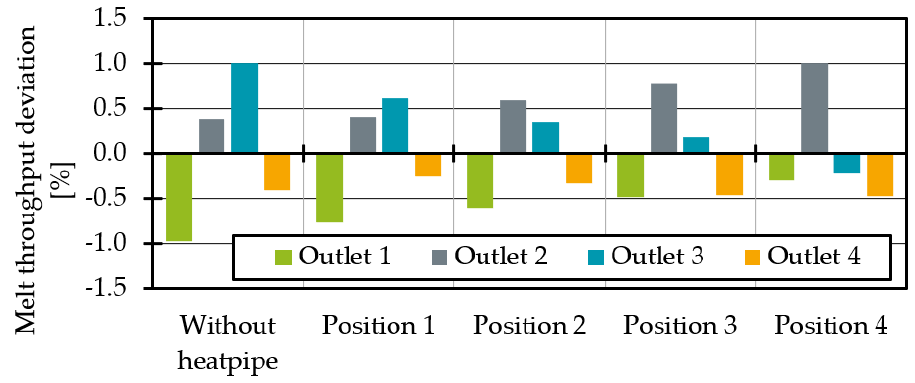
Figure 12. Melt throughput deviation at each outlet for different heat pipe positions.